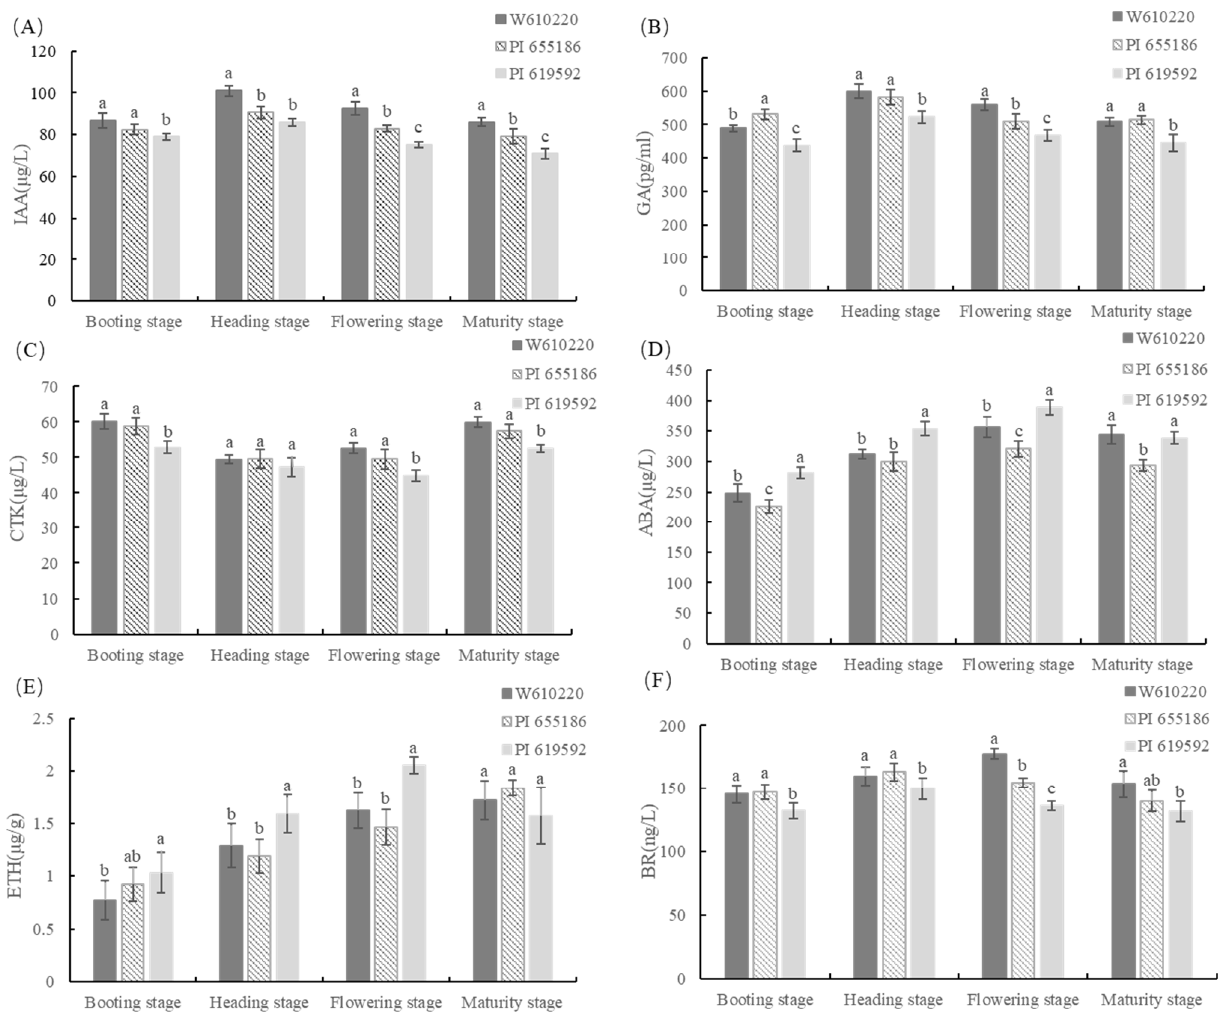
Figure 8. Hormonal changes of awns of three accessions at four developmental stages: ( A ) Auxin, ( B ) Gibberellin, ( C ) Cytokinin, ( D ) Abscisic acid, ( E ) Ethylene, ( F ) Brassinolide. Error bars represent mean ± standard deviation. Different normal letters mean significant differences among different treatments at 0.05 level.